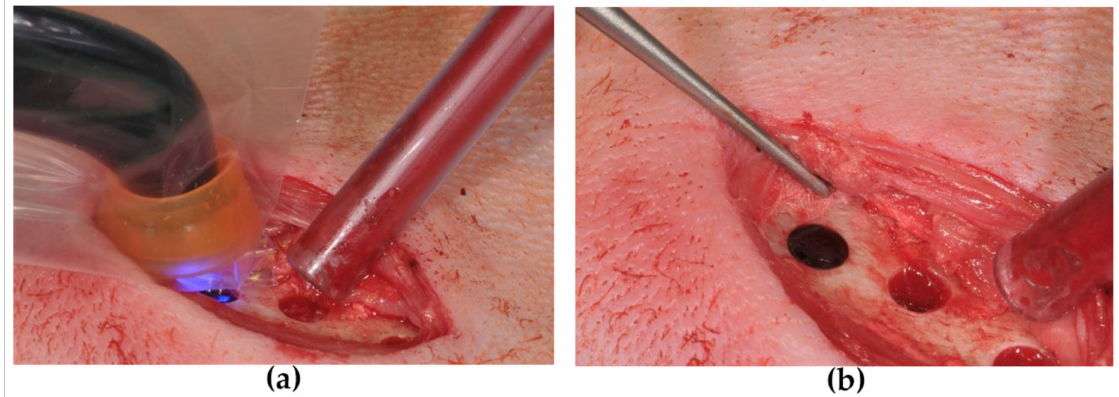
Figure 7. Biomaterial application: ( a ) light-polymerization; ( b ) solid biomaterial in the